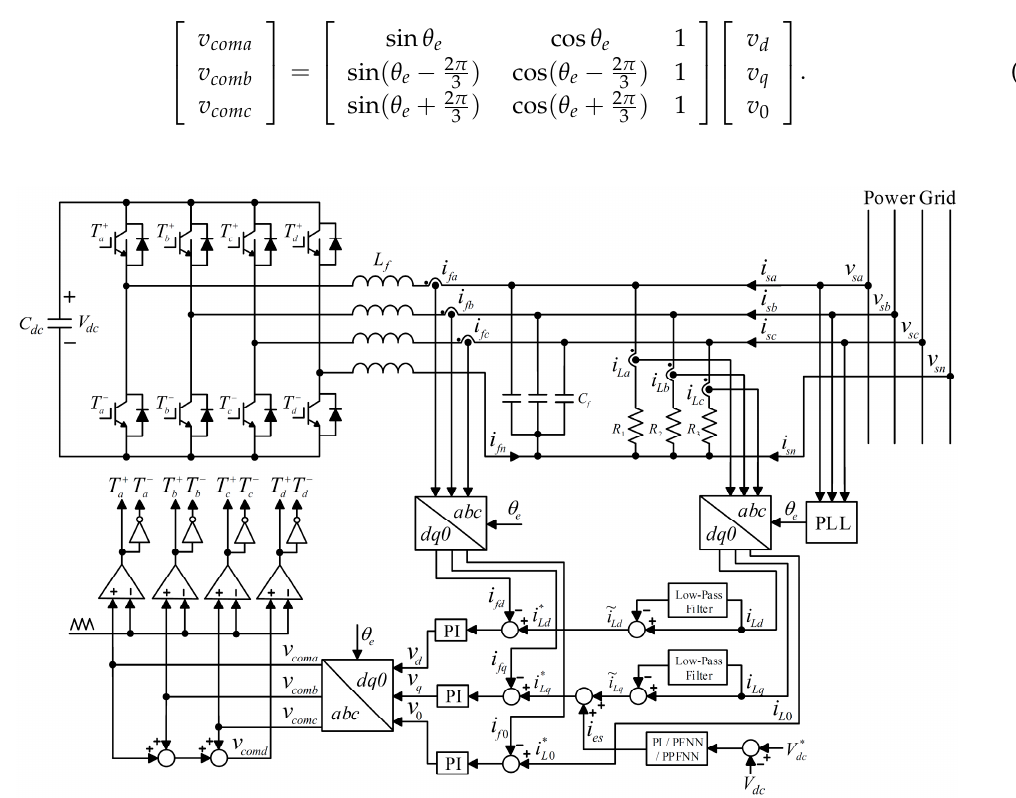
Figure 2. Control scheme of shunt APF.